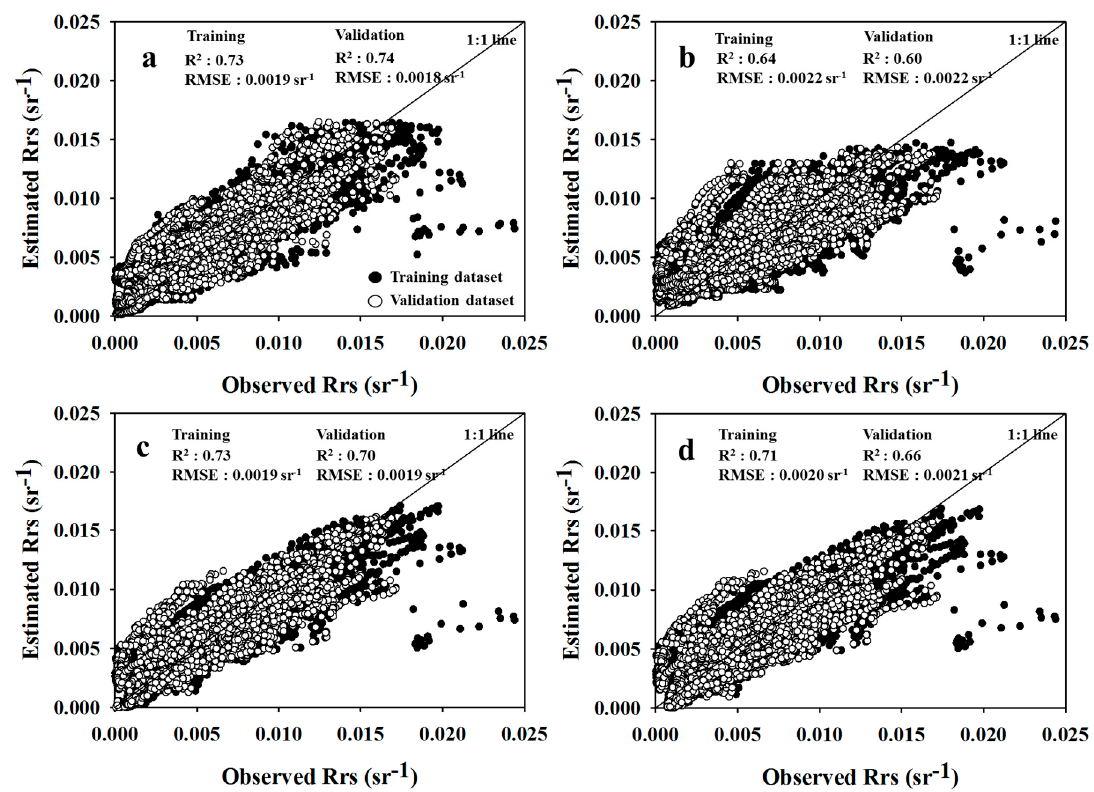
Figure 4. Training and validation results of the atmospheric correction: ( a ) SAE-ANN, ( b ) ANN, ( c ) SAE-SVR, and ( d ) SVR. A total of 134 observation points is presented. Each point had observed reflectance spectra with 86 bands, indicating 11,524 (i.e., 134 × 86) points, comparing the estimated reflectance spectra to the observed spectra of total bands. Black and white dots indicate training and validation results, respectively